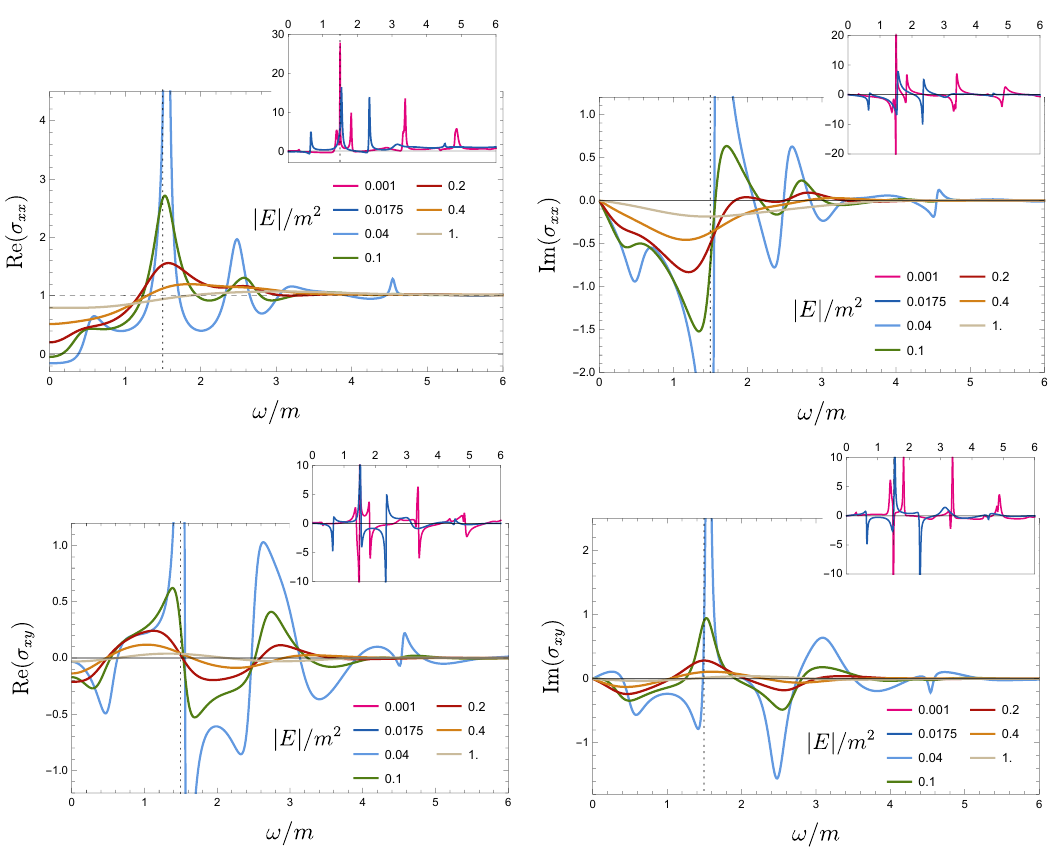
Figure 10 . AC conductivities for (cid:12)xed value of (cid:10) =m = 1 : 496 and di(cid:11)erent values of j E j =m 2 . They correspond to the vertically aligned dots in (cid:12)gure 12 with the same color code. In the insets, the curves at low values of j E j =m 2 ! 0 deep into the critical wedge, where they develop peak resonances. The value !=m = (cid:10) =m = 1 : 496 is signalled with a dashed vertical